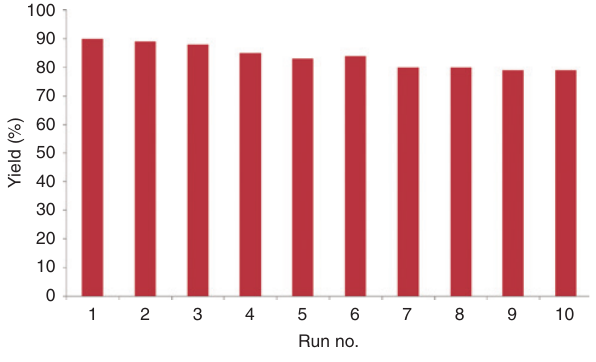
Figure 4: Catalyst